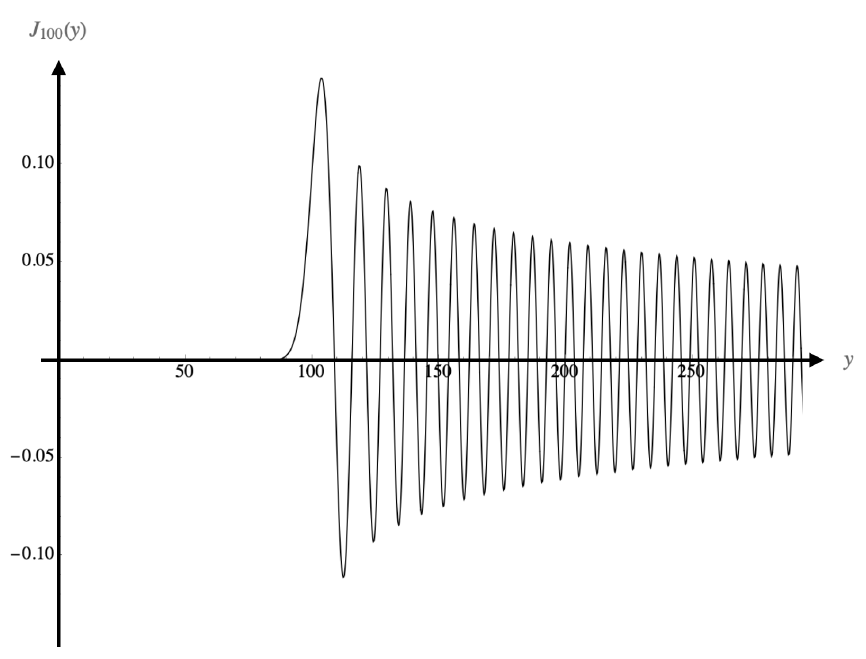
Figure 5. The Bessel function J 100 ( y ) . It displays a transition from the power- to the harmonic regime near y = 100